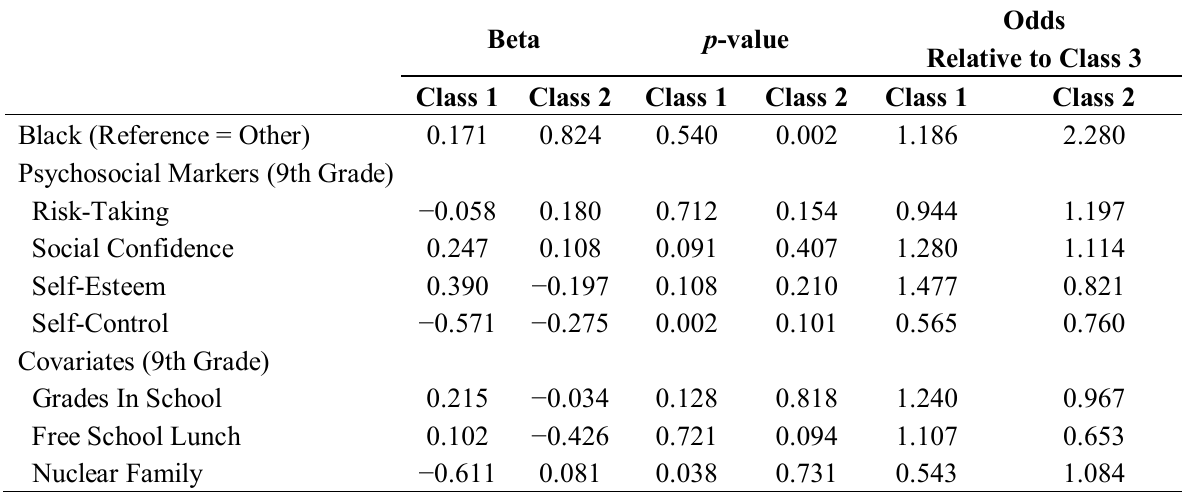
Table 3. Relative odds of latent class